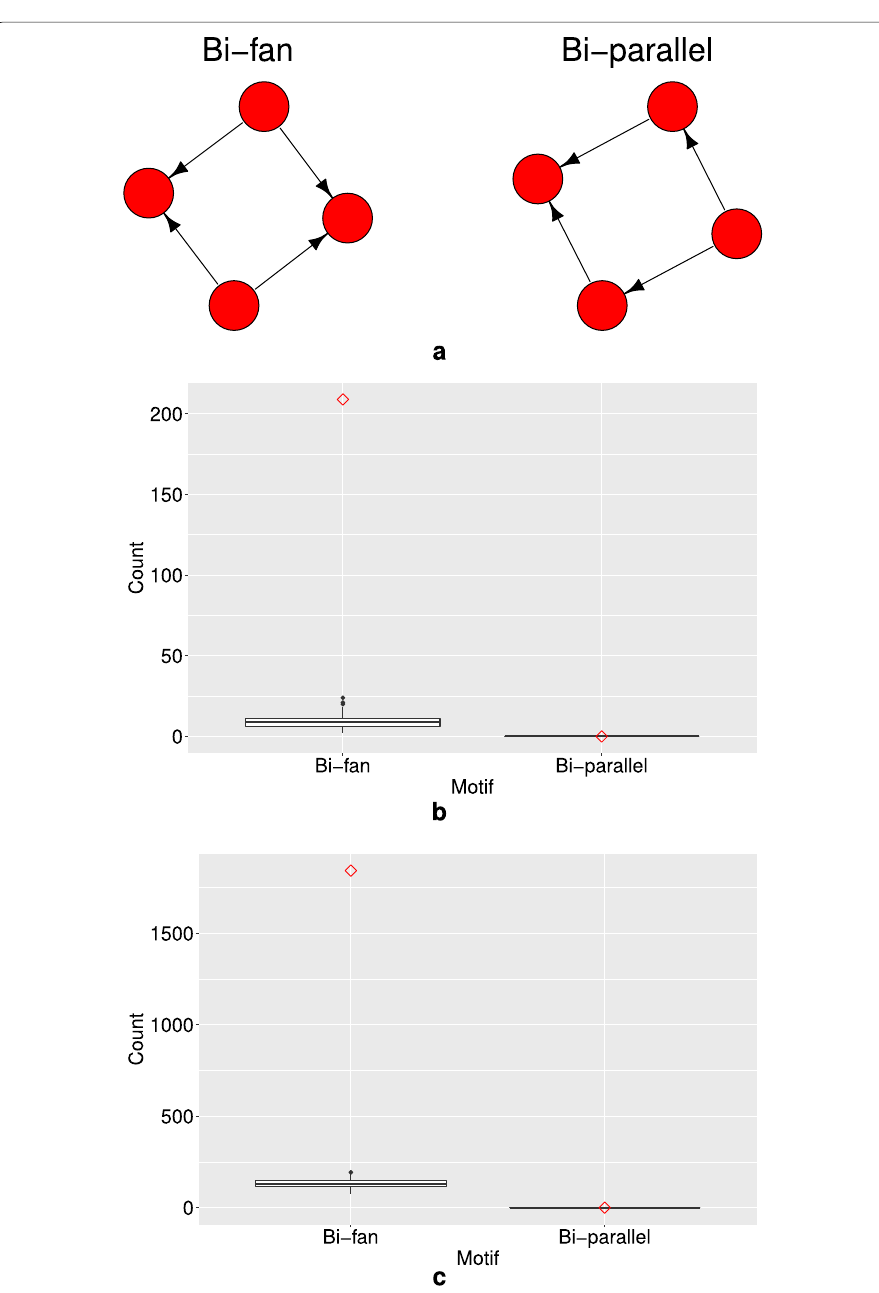
or arc) formation, not for motif formation: if we consider ERGM as a type of logis- tic regression, the outcome variable is the presence or absence of a network tie. The predictor variables are not independent of each other, but form a nested hierarchy of configurations: triangles are formed by “closing” a two-path with an additional